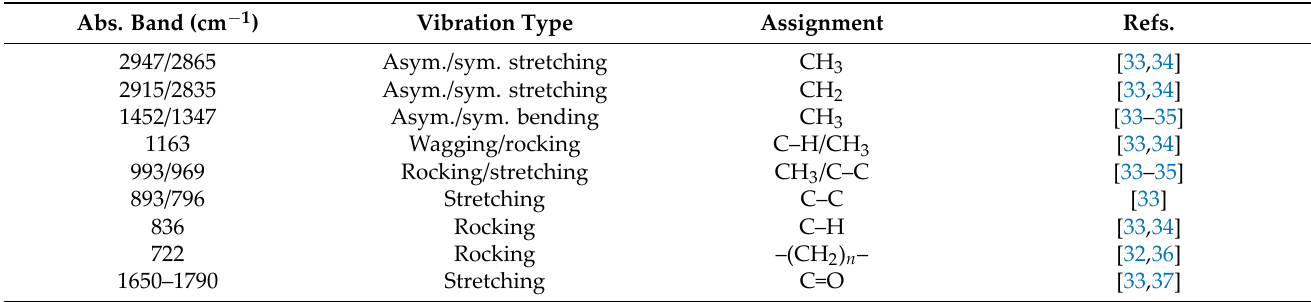
Table 3. FTIR characteristic peak wavenumbers of PP before and after oxidation.